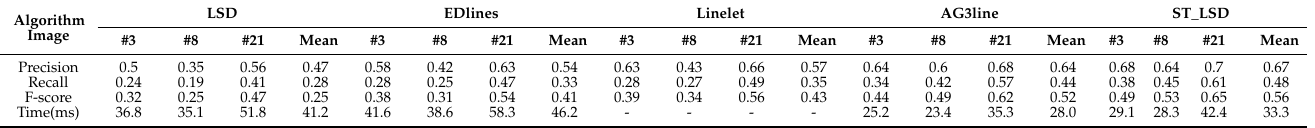
Table 2. Quantitative evaluation of the performance on images no. 3, 8, and 21 of the